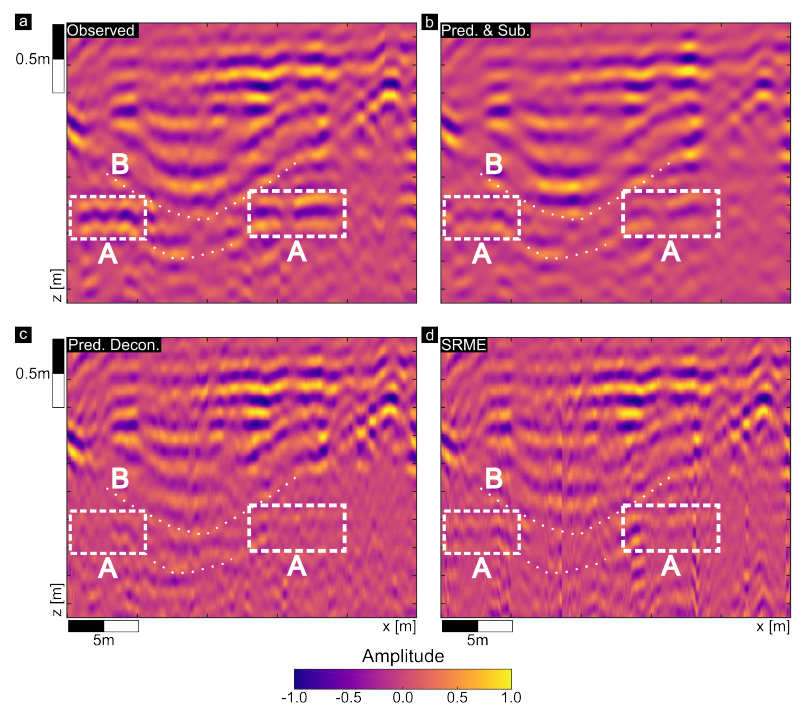
Figure 13. Detail 1 of the constant-offset section of field data set 2. The observed data ( a ) and results of three multiple attenuation approaches ( b – d ) are compared. The first water-layer multiple is highlighted with white boxes (A). The enhanced reflector of is marked by a white dotted line (B).